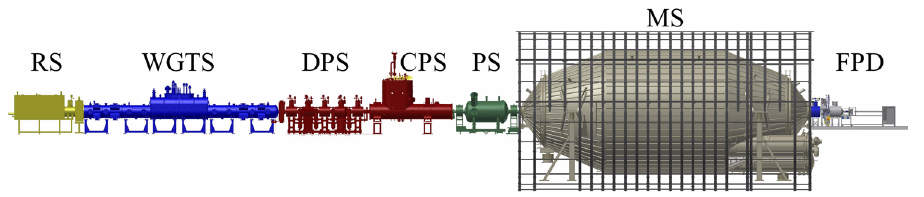
Fig. 1 The KATRIN beamline. From left to right: the rear section (RS), the windowless gaseous tritium source (WGTS), the differen- tial pumping section (DPS), the cryogenic pumping section (CPS), the